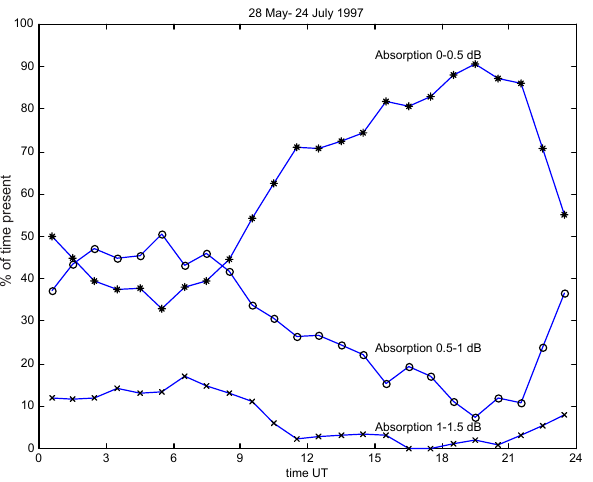
Fig. 3. Scatter plot of linear signal-to-noise ratio versus the square of absorption for the mean daily variations for the period 28 May– 24 July 1997. Data have been averaged over the entire interval, binned into 1-hUT time